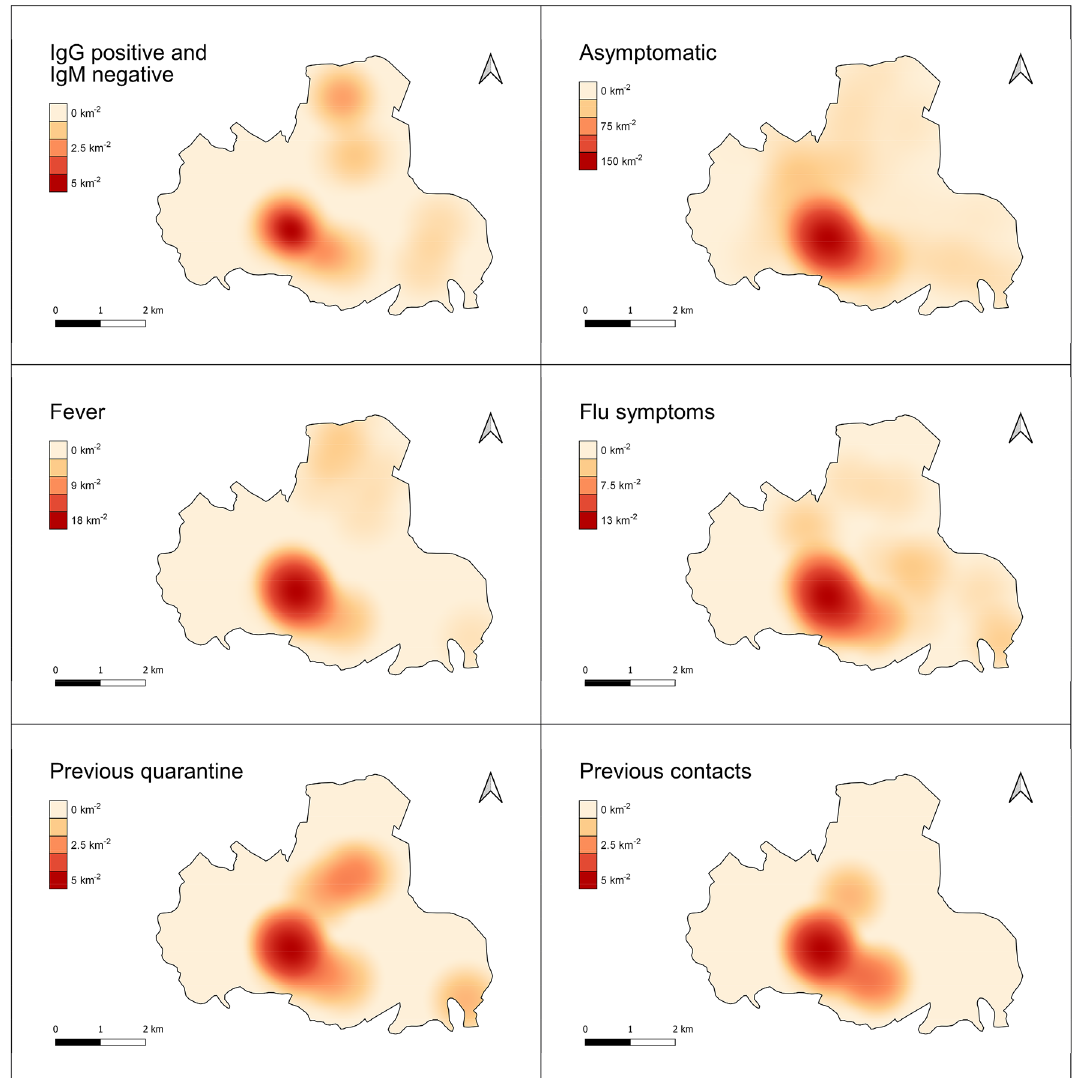
Figure 6. Maps showing the spatial density (individuals km −2 ) of percentage of specific case